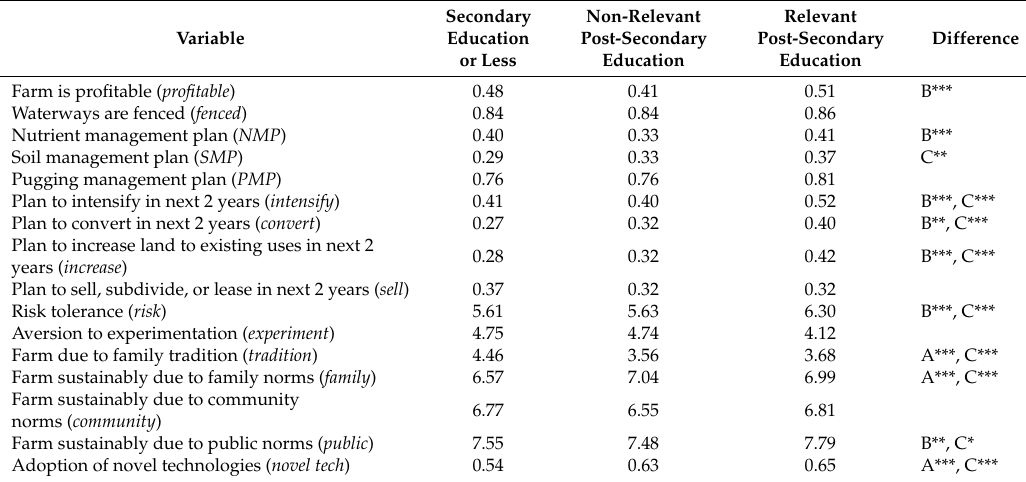
Table 2. Summary Statistics by relevance of education.